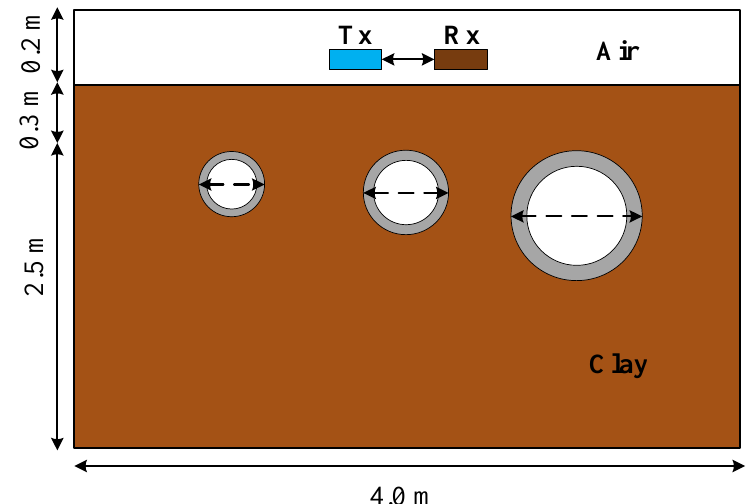
Figure 12. Underground multi-pipe model with different pipe diameters.